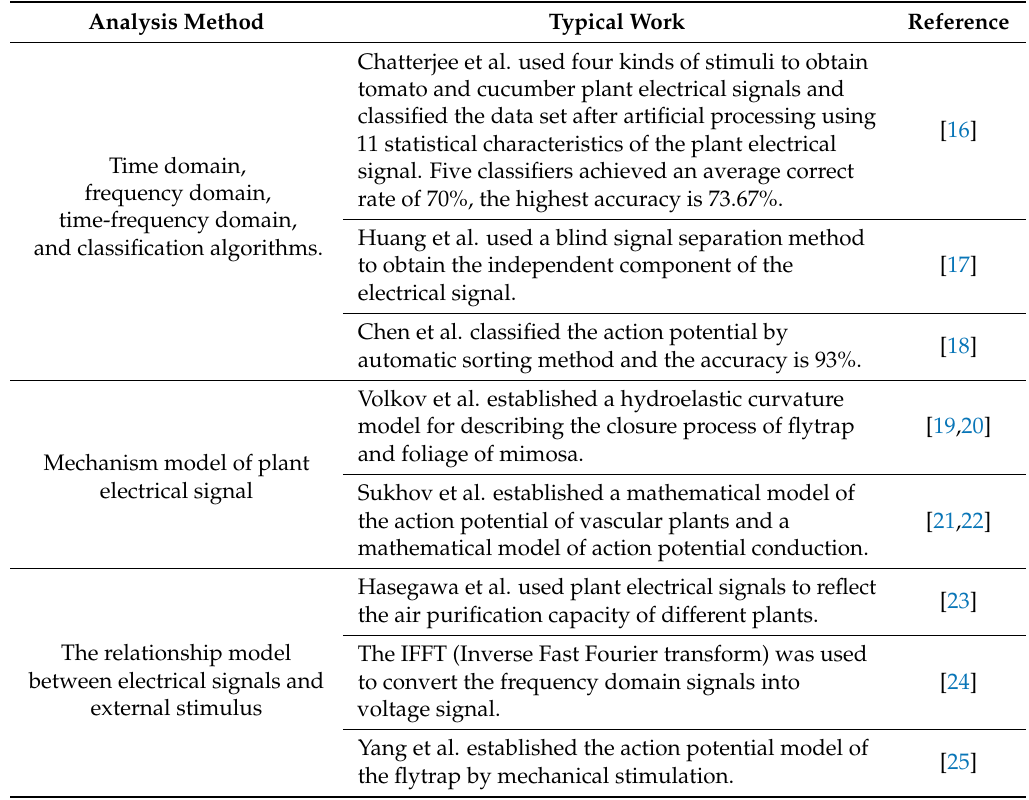
Table 2. Three types of methods for plant electrical signals